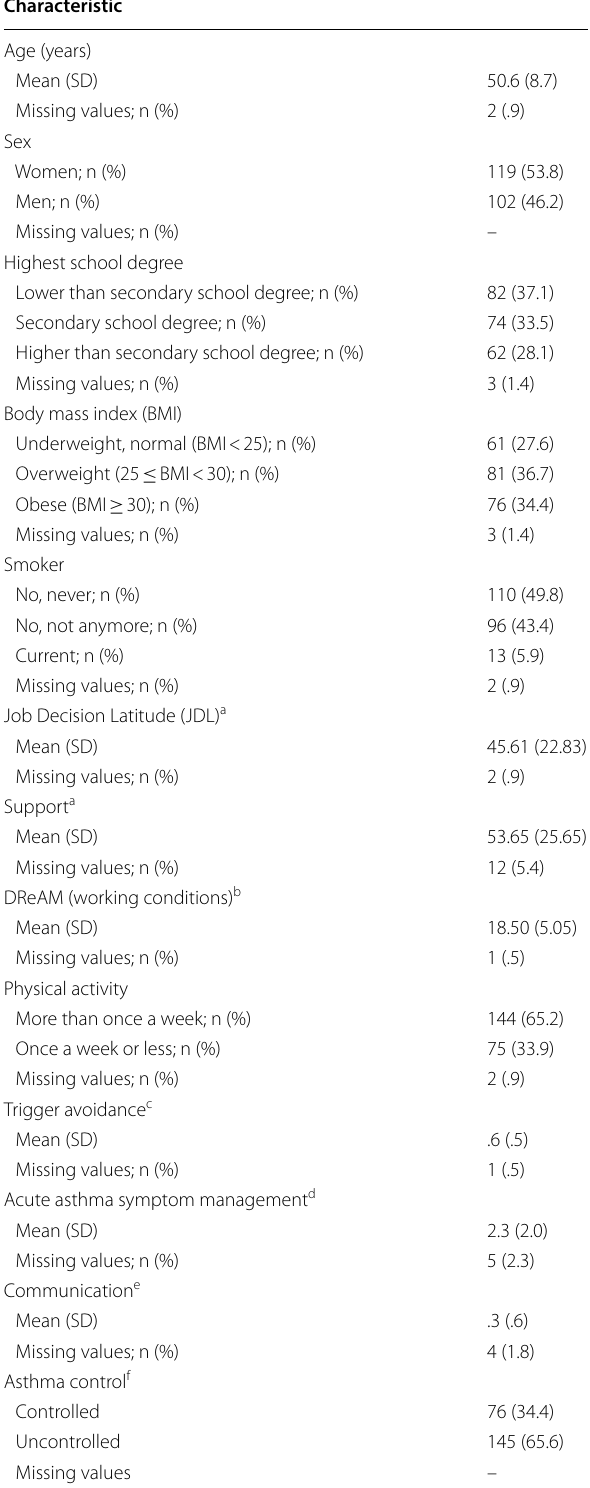
Table 2 Sample characteristics (n